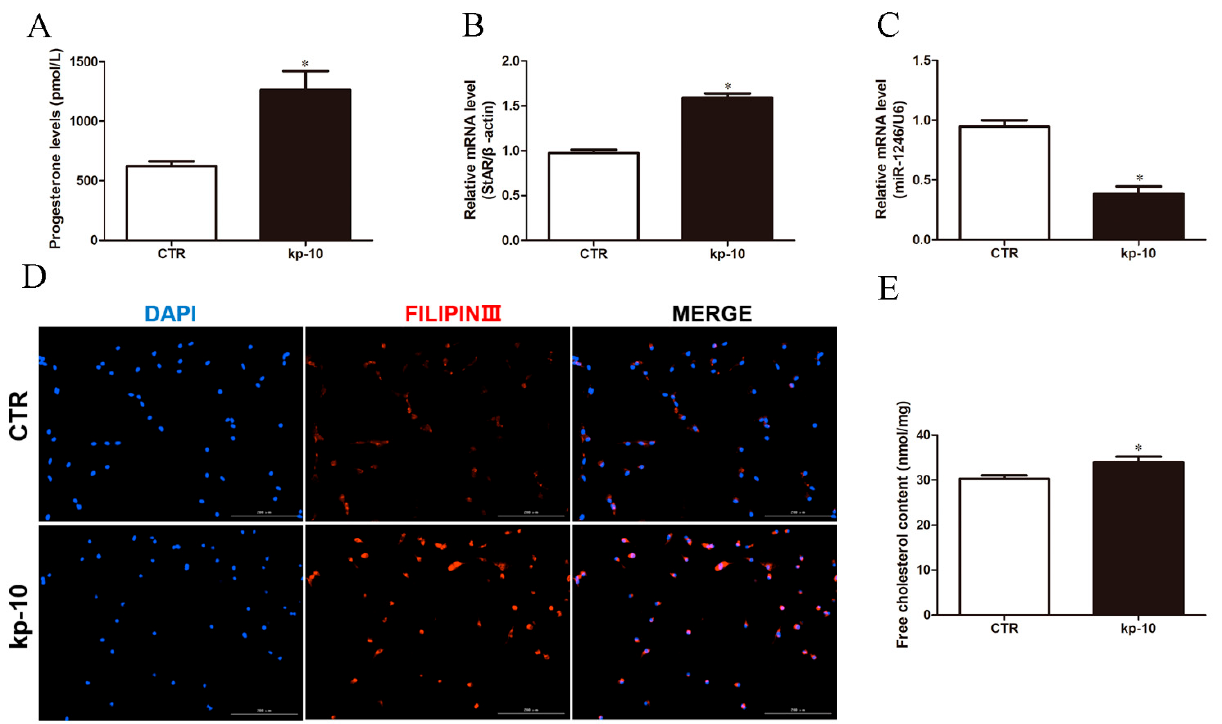
Figure 1. kp-10 promotes P4 synthesis and reduces miR-1246 expression in BGCs. ( A ) The level of P4 in BGCs. ( B, C ) The relative mRNA expression of StAR and miR-1246 in BGCs. ( D ) Representative filipin staining of BGCs. ( E ) Relative content of free cholesterol in BGCs. All data were presented as the mean ± SD ( n = 3), * p < 0.05.